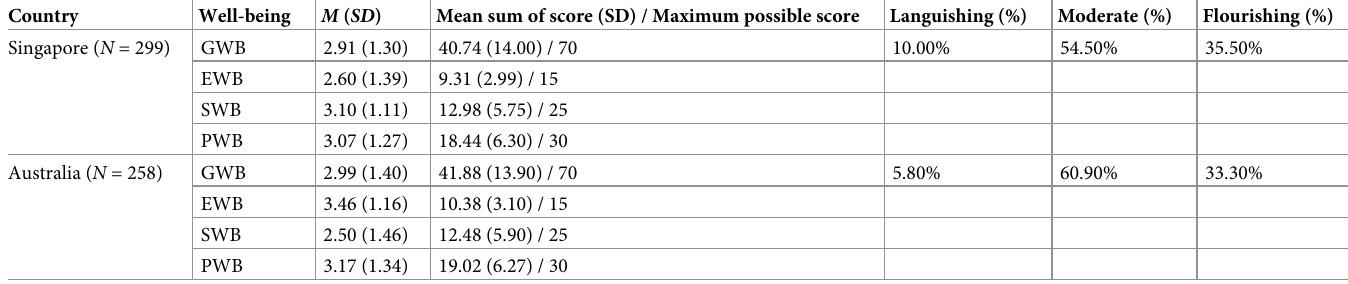
Table 3. Descriptive statistics, continuous scores, and categorical results of the MHC-SF. Country Well-being M ( SD ) Mean sum of score (SD) / Maximum possible score Languishing (%) Moderate (%) Flourishing (%) Singapore ( N =